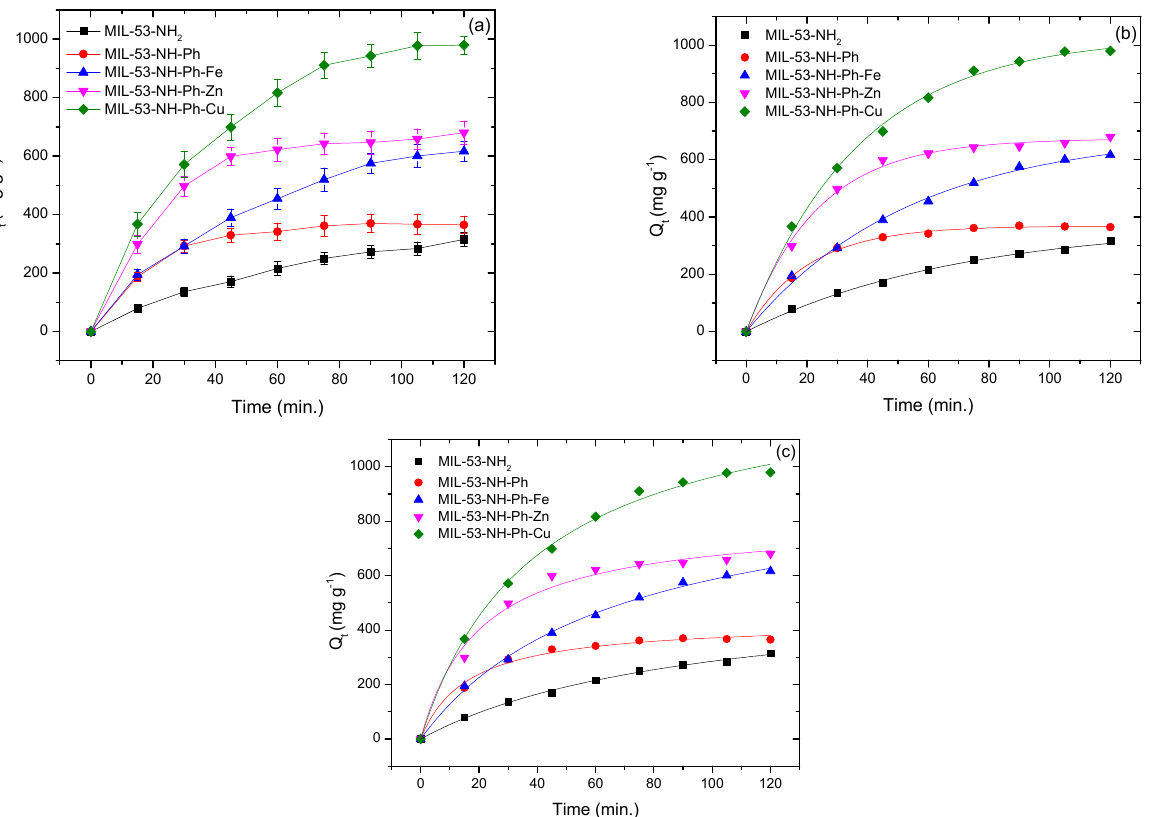
Figure 9. ( a ) Effect of time on adsorption of carbofuran onto MIL − 53 − NH 2 , MIL − 53 − NH − ph, MIL − 53 − NH − ph − Fe, MIL − 53 − NH − ph − Zn, and MIL − 53 − NH − ph − Cu; ( b ) pseudo first order fitting; and ( c ) pseudo-second-order fitting. (Dosage: 30 mg L − 1 , speed = 400 rpm, pesticide concentration: 30 mg L − 1 , pH: 7, and T = 303 k).